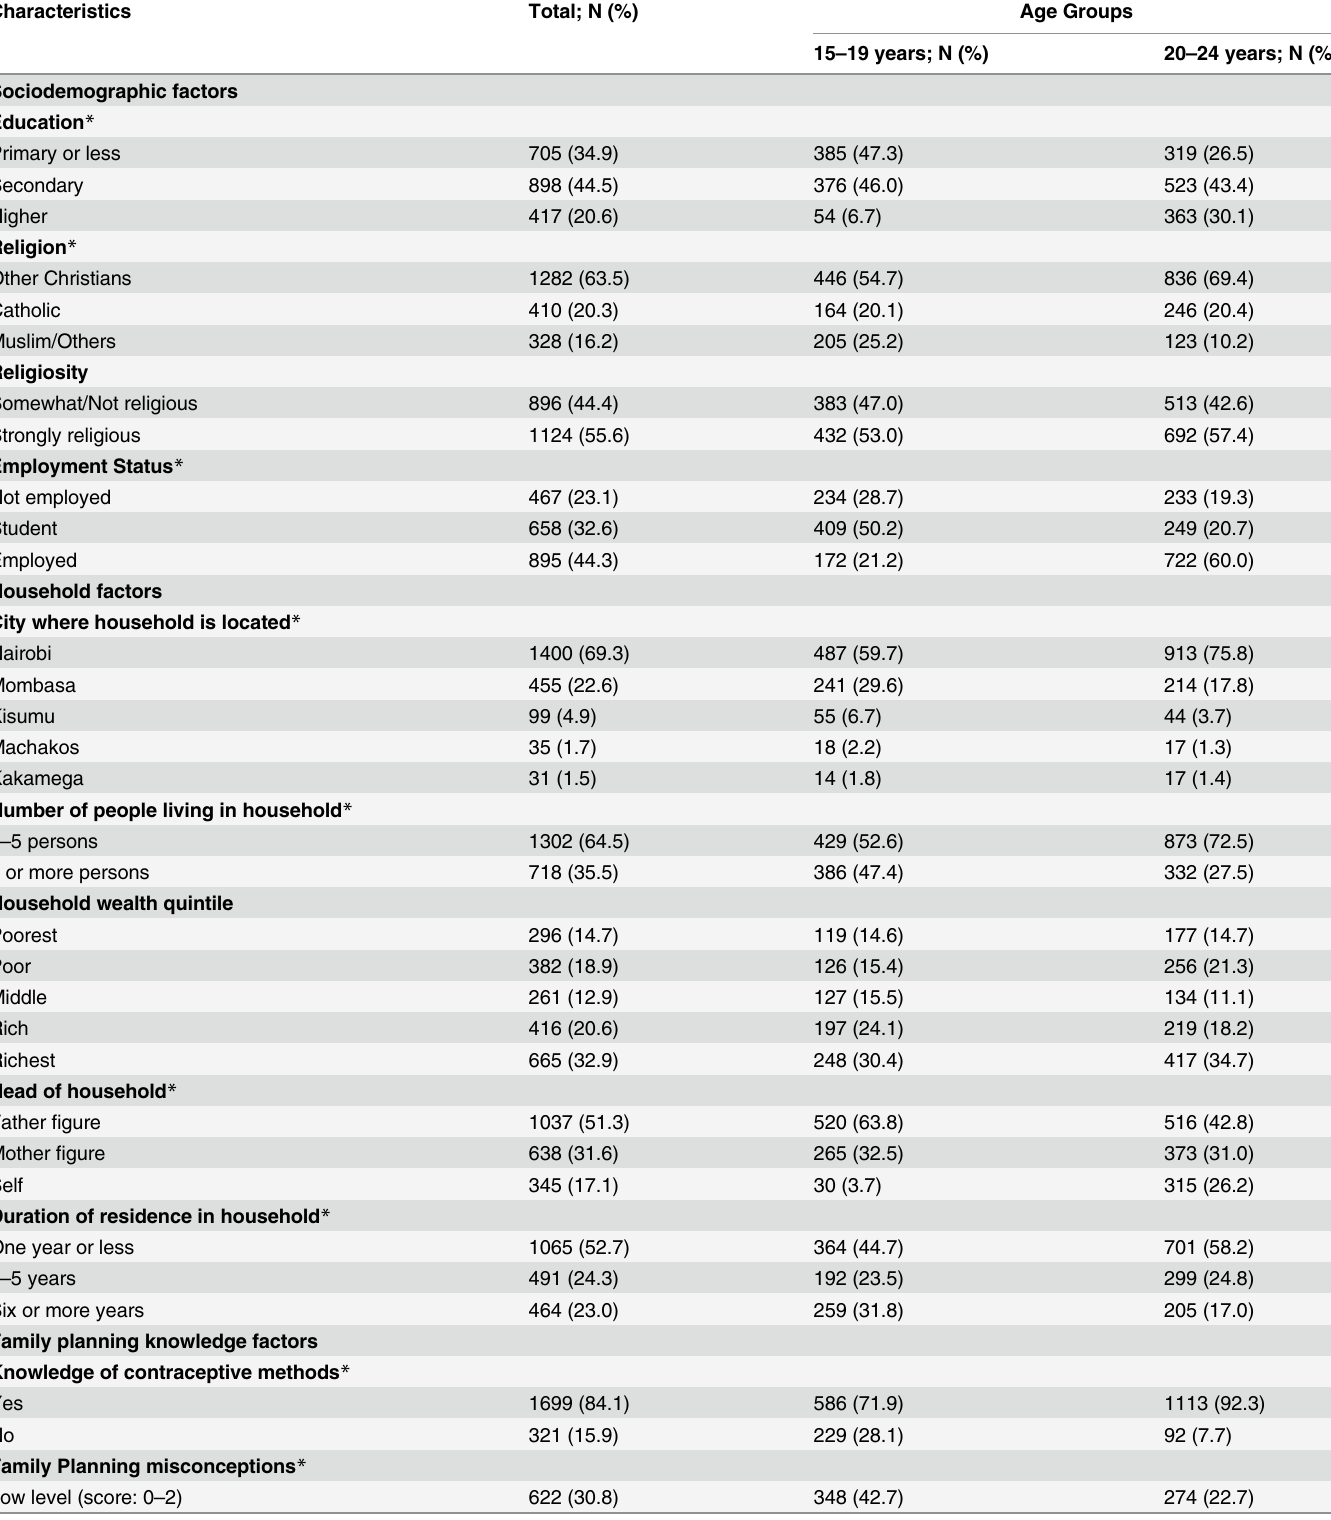
Table 1. Descriptive characteristics of never-married women aged 15 – 24 years in urban